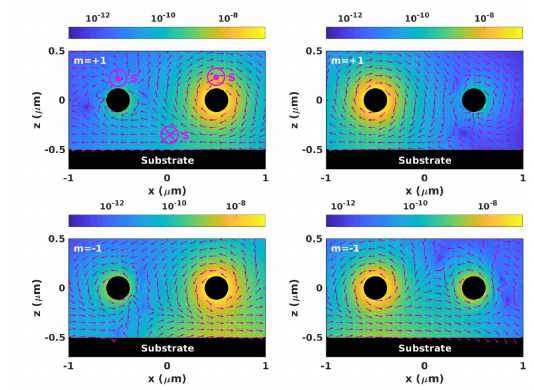
Figure 1. Directional spectral heat flux in forward and backward direction due to the coupling of the m = ± 1 resonances with the spin-momentum locked non-reciprocal surface modes for